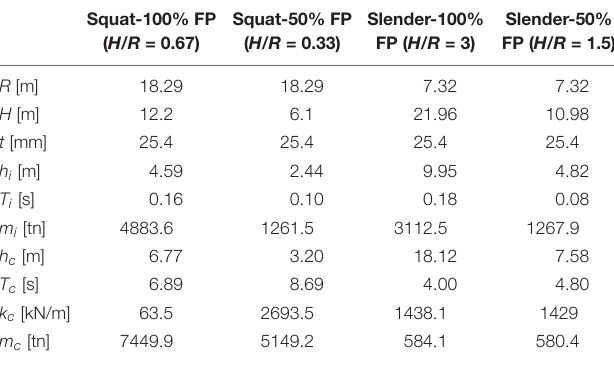
TABLE 2 | Model parameters for the squat and the slender tank with 50 and 100% FP. Squat-100% FP ( H/R =